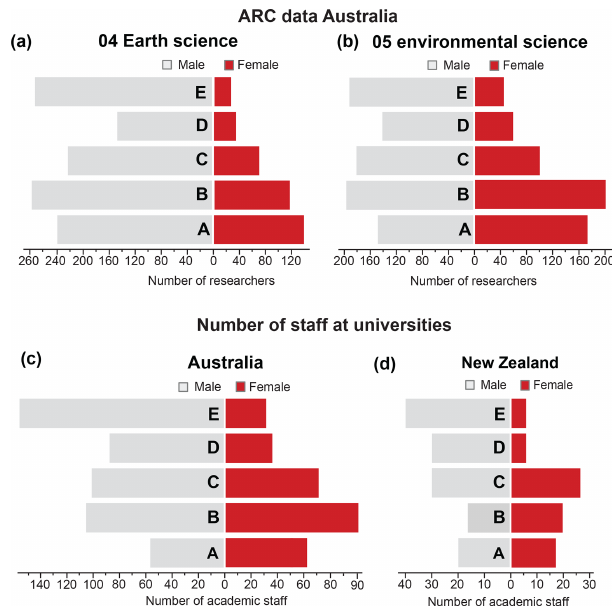
Figure 1. Staff profile by headcount reported by the Australian Re- search Council (ARC) Excellence in Research for Australia (ERA) 2018 evaluation (Australian Research Council, 2019). Data dis- played by two-digit Fields of Research for (a) Earth Sciences (FoR 04) and (b) Environmental Sciences (FoR 05). Note ERA 2018 data only considers staff reported as female or male and ex- cludes 40 staff that were reported as “X” in ERA 2018. Headcount of women working in Geosciences within the top 10 universities in Australia (c) and top 6 in New Zealand (d) according to the Quacquarelli Symonds (QS) World University Rankings and The Times Higher Education World University Rankings for 2019. The employment levels considered included academic levels A to E, where: Level A represents Associate or Assistant Lecturer/Research Associate, Level B represents Lecturer/Research Fellow, Level C represents Senior Lecturer/Senior Research Fellow, Level D repre- sents Associate Professor/Reader and Level E represents Professor. See Sect. 3.1 and Table S1 for additional